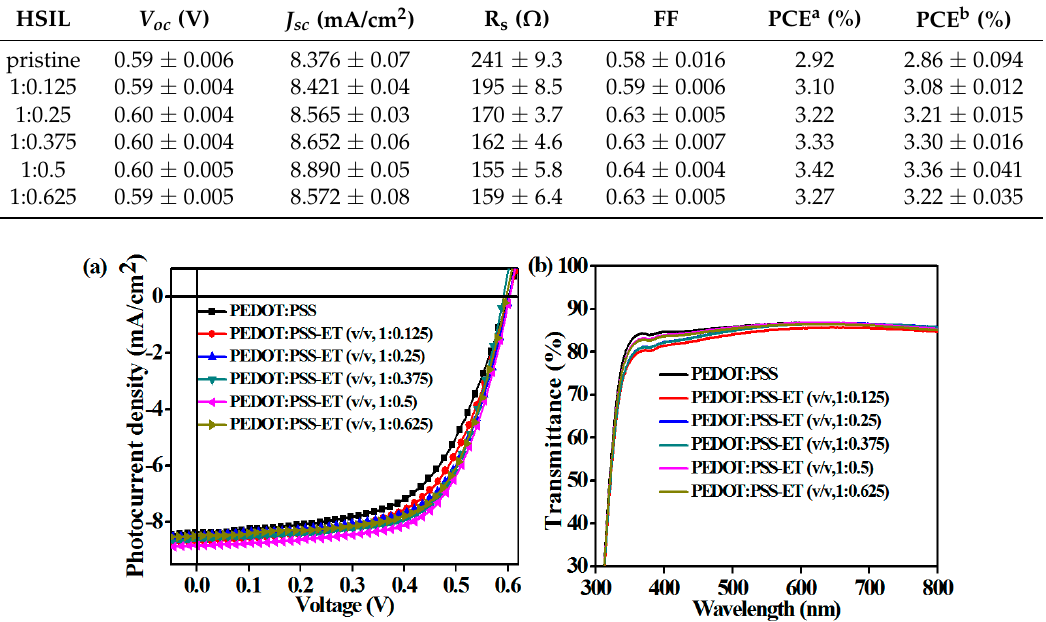
Figure 2. ( a ) J-V characteristics of the BHJ-PSCs fabricated with PEDOT:PSS and PEDOT:PSS-ET